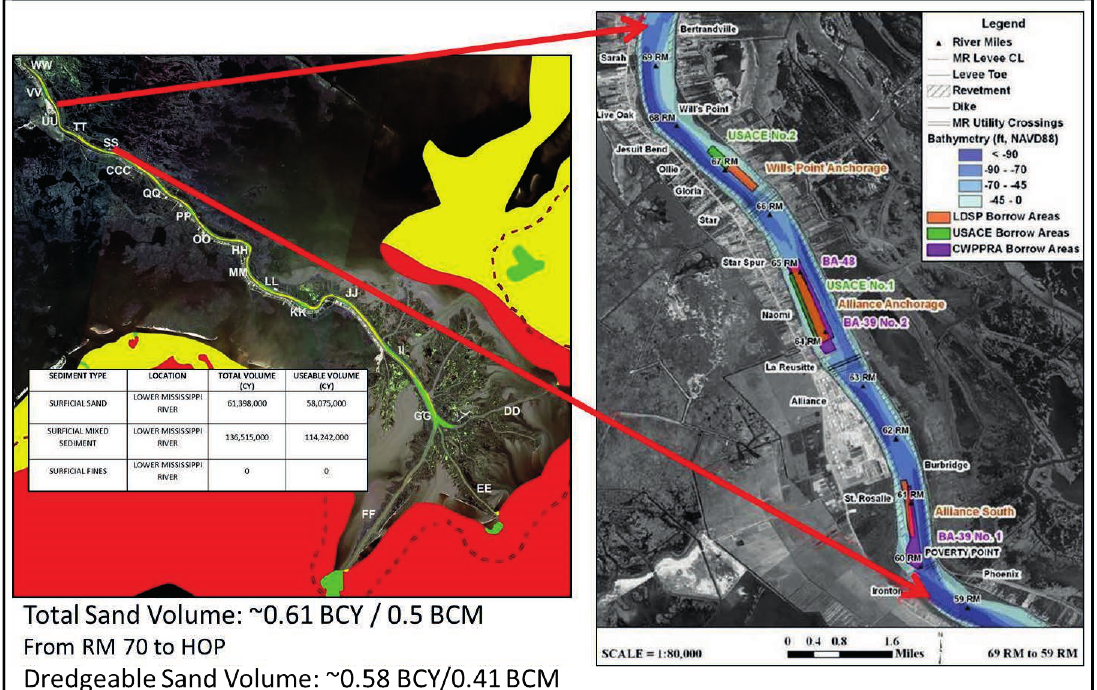
Fig. 3 First-order assessment of Lower Mississippi River sand and mixed sediment